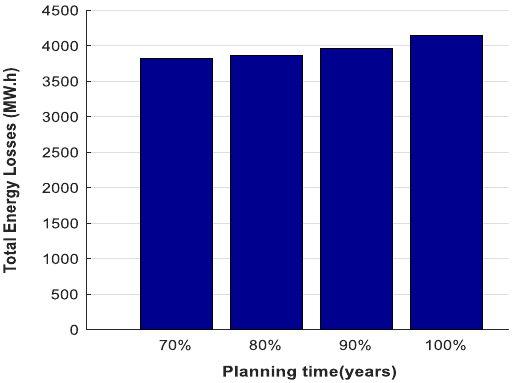
Figure 7. Total energy losses for the planning in each of the scenarios simulate.